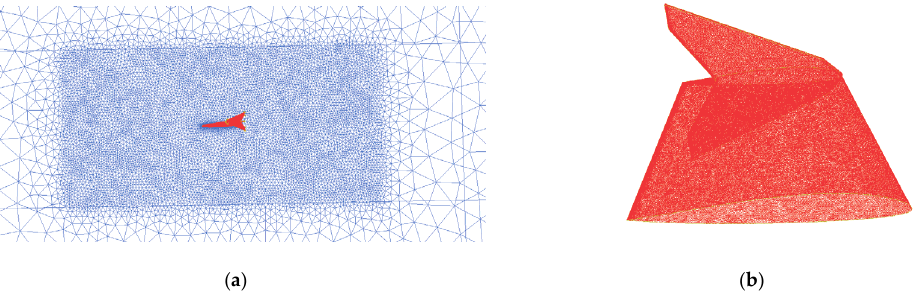
Figure 3. Outflow mesh. ( a ) local mesh refinement; ( b ) UAV surface mesh.